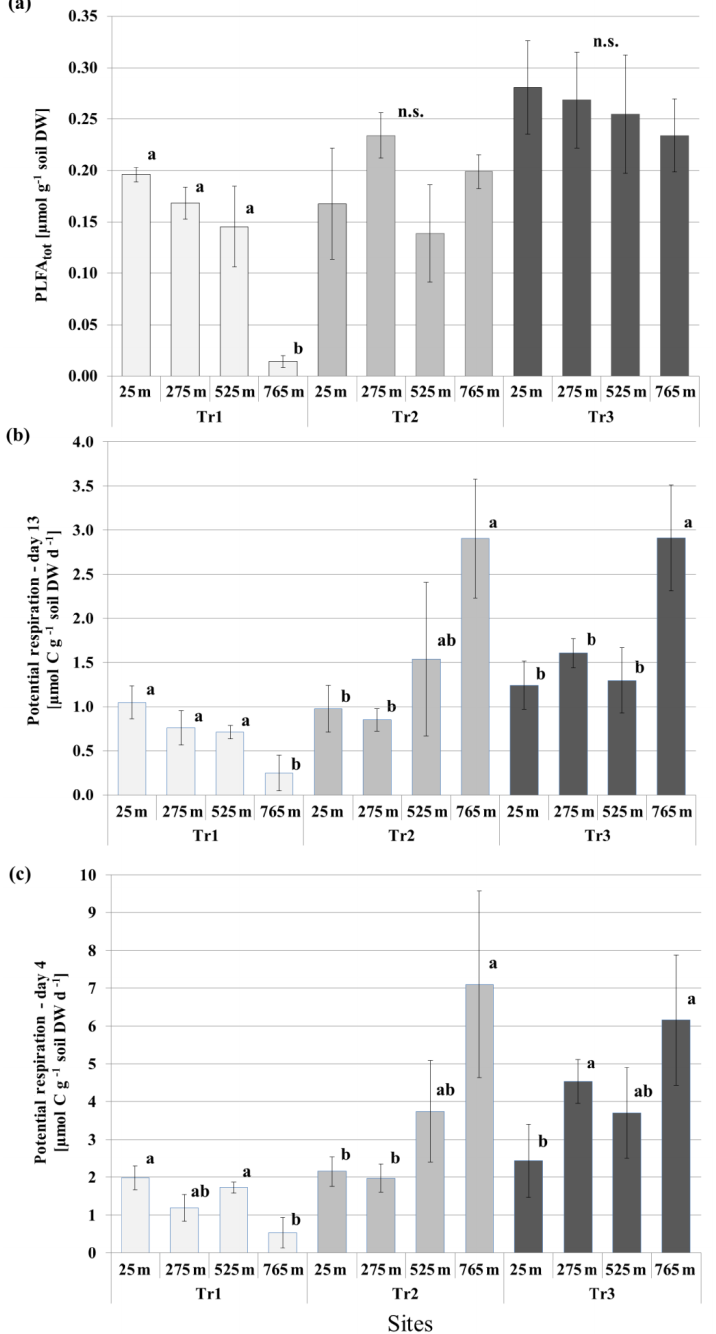
Figure 2. The soil PLFA contents (a) and potential respiration rates measured at day 13 (b) and at day 4 (c) in soils from different elevations along three altitudinal transects (Tr1–Tr3). Error bars indicate mean ± SD ( n = 3). Lowercase letters denote significant differences between altitudes within particular transects ( P <0.05; one-way ANOVA combined with Tukey post hoc test).